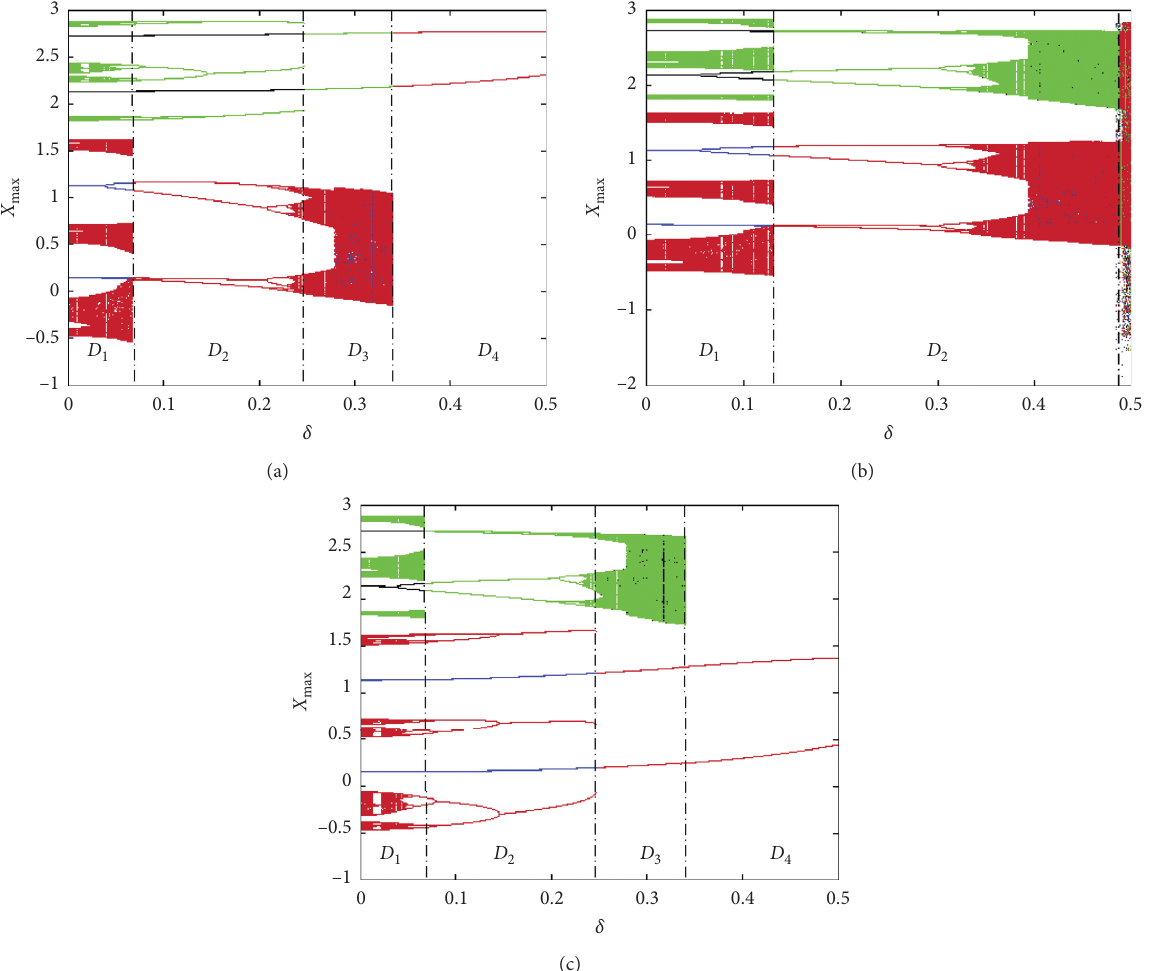
Figure 5: Bifurcation diagrams showing local maxima of the state variable x versus the control strength δ in the range 0 0 . 5 􏼂 􏼃 of the controlled system (see equation (4)) showing multistability control with selection of attractors for different values of ε . Four separated diagrams are superimposed when increasing the coupling strength δ for four different initial conditions. Red is obtained with (− 0 . 56 ; 0 ; 0 ; 0 ) , the one in black is obtained for ( 1 . 6 ; 0 ; 0 ; 0 ) , blue is obtained with (− 1 . 6 ; 0 ; 0 ; 0 ) , and the one in green is obtained for ( 0 . 56 ; 0 ; 0 ; 0 ) . (a) For ε � 2 . 1438, (b) for ε � 0, and (c) for ε � − 2 . 1438. For these diagrams, η � 1 and β � 53 . 8. Other parameters are those of Figure 1.